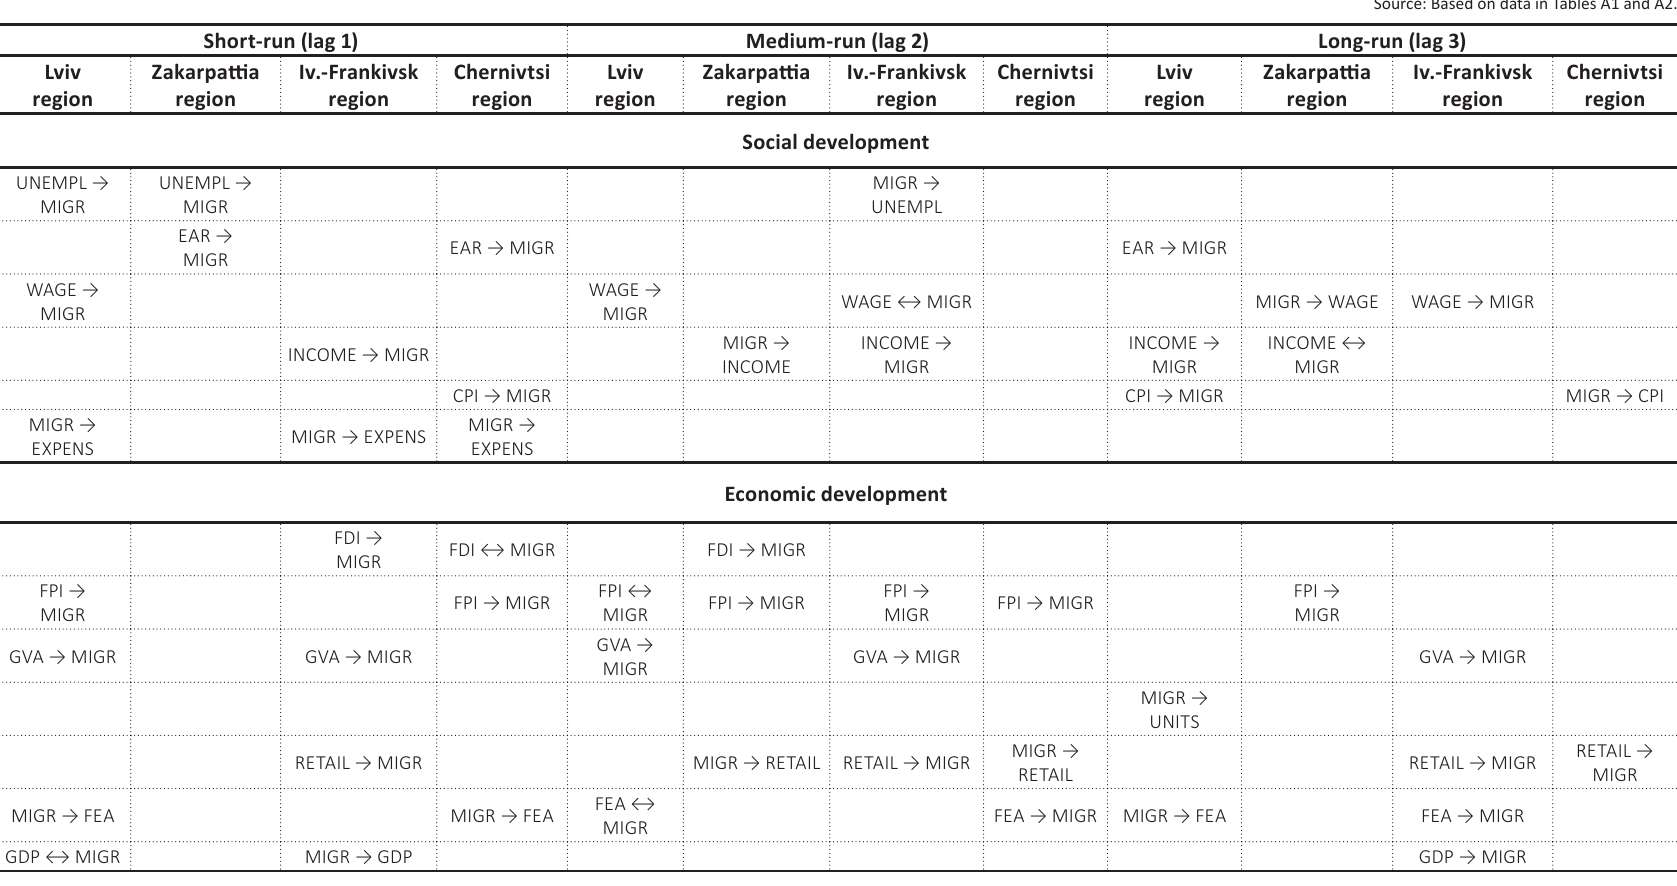
Table A3. The causal relationship between population migration and social and economic development of the Carpathian Region